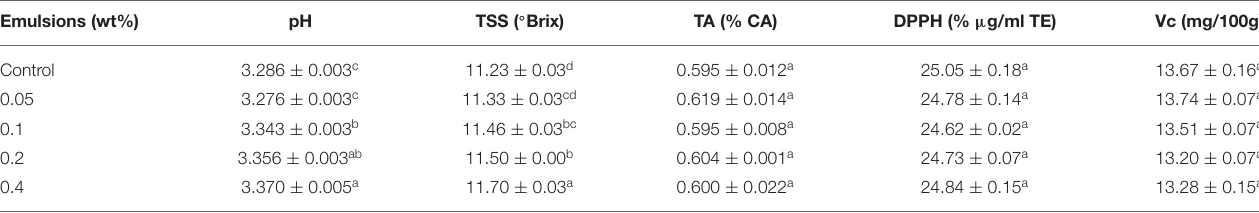
TABLE 2 | Changes in the physicochemical properties (pH, TSS, TA, DPPH, Vc) of the pineapple juice treated by galangal essential oil emulsion at room temperature. Emulsions